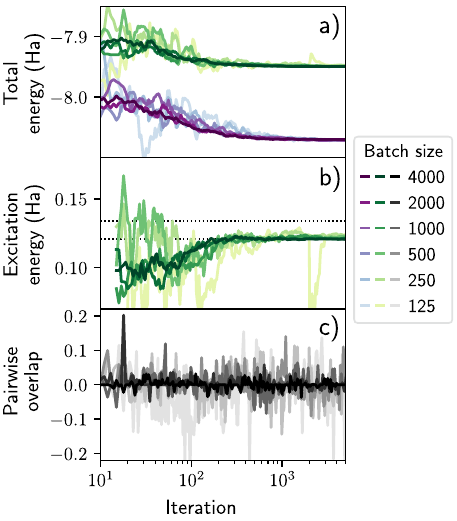
Fig. 7 | Behavior of the loss function with batch size. The ground state and fi rst excited state of LiH are approximated. The convergence of the total energies ( a ), excitation energy ( b ), and the pairwise overlap between the wavefunctions ( c ) are shown. Dotted horizontal lines are excitation energies from highly accurate references 57,58 . While the optimization works well for the large batches that we typicallyemployinourcalculations( ≥ 2000),thisbecomeslessreliable,atleastfor the excited state, in the limit of smaller batch sizes. Note: Darker corresponds to a larger batch size in each respective color.